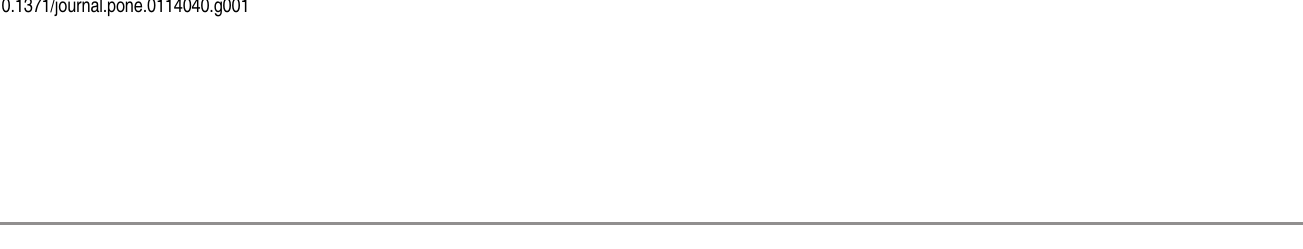
Figure 1. Measured DOM concentrations (1a) and d 13 C values of the DOM (1b) in the soil water (mean ¡ standard error) under treatments with only labeled beech (Be*; n 5 6), labeled ash (As*; n 5 6), mixed ((BeAs)*; n 5 12) and unlabeled litter treatments (unlabeled; n 5 18). The dashed lines subdivide the experiment into the two winter (I: 16.12.08–30.03.09; II: 21.12.09–22.03.10) and two summer periods (I: 20.04.09–30.11.09; II: 07.04.10–